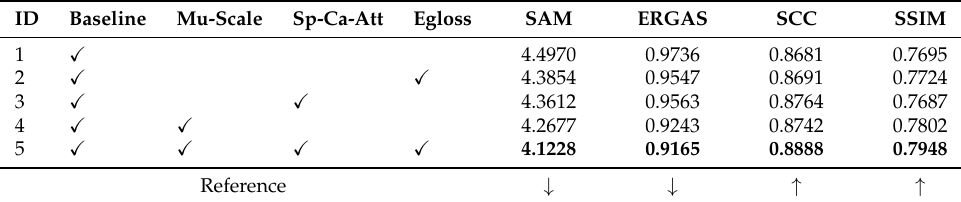
Table 2. Performance of different modules on the LGC